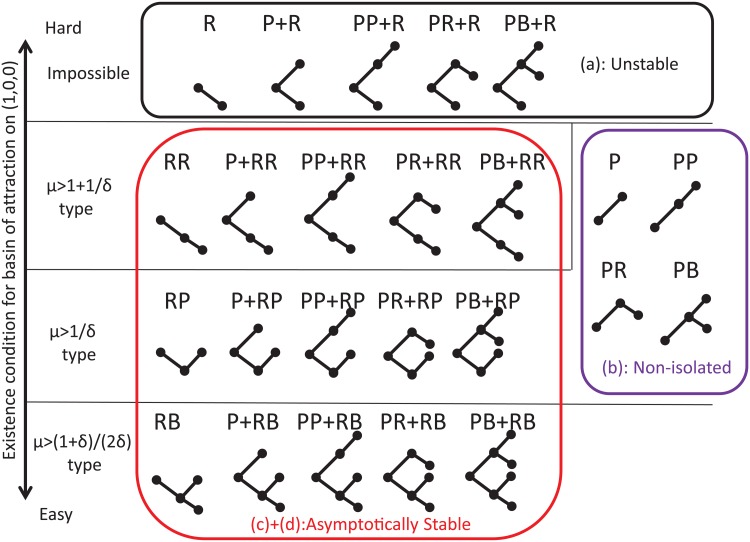
Illustration of replicator dynamics analyses for each type of S-MIG.This figure illustrates all 24 types of S-MIG. The abbreviations are defined in Table 1. Their vertical layering in the figure reflects the existence condition for the basin of attraction on the point (x, y, z) = (1, 0, 0) related to (μ, δ) under which a cooperative regime emerges. The frames represent the form of local stability at point (x, y, z) = (1, 0, 0): the point is unstable for each type in the top frame which corresponds to (A) in Fig 3, is a non-isolated equilibrium for each type in the bottom right frame which corresponds to (B) in Fig 3, and is asymptotically stable for each type in the bottom left frame which corresponds to (C) and (D) in Fig 3.